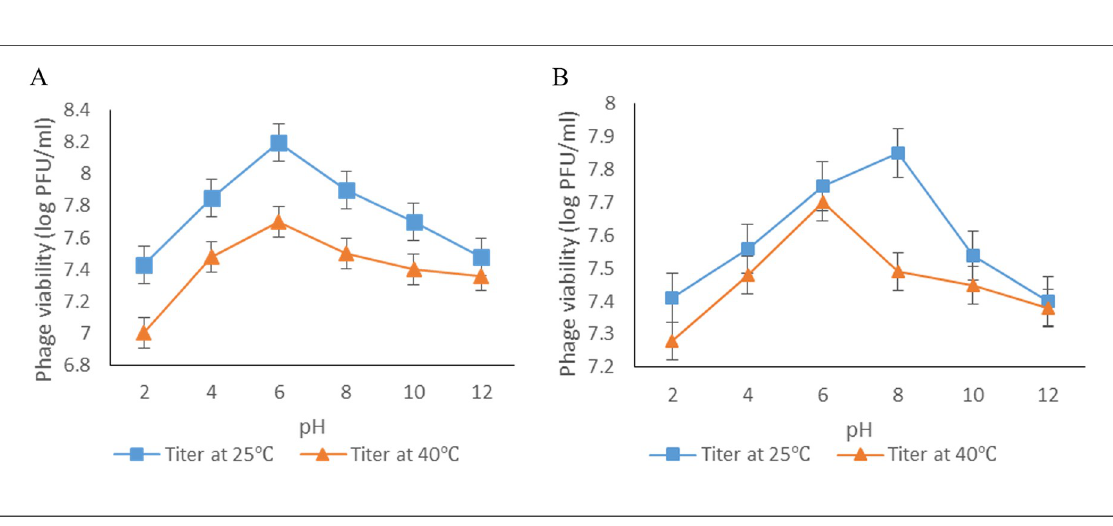
The stability of UPEC04 and UPEC10 to pH ranges from 2 to 12 at both 25˚C and 40˚C is pre- sented in Fig 5. The phages retained viability across the different pH values with the lowest titers registered at the extremes of pH (2 and 12), while the highest titers were registered between pH 4 and 8. The changes in the titers followed a similar pattern at the two tempera- tures, though the titers were consistently higher at 25˚C compared to 40˚C.